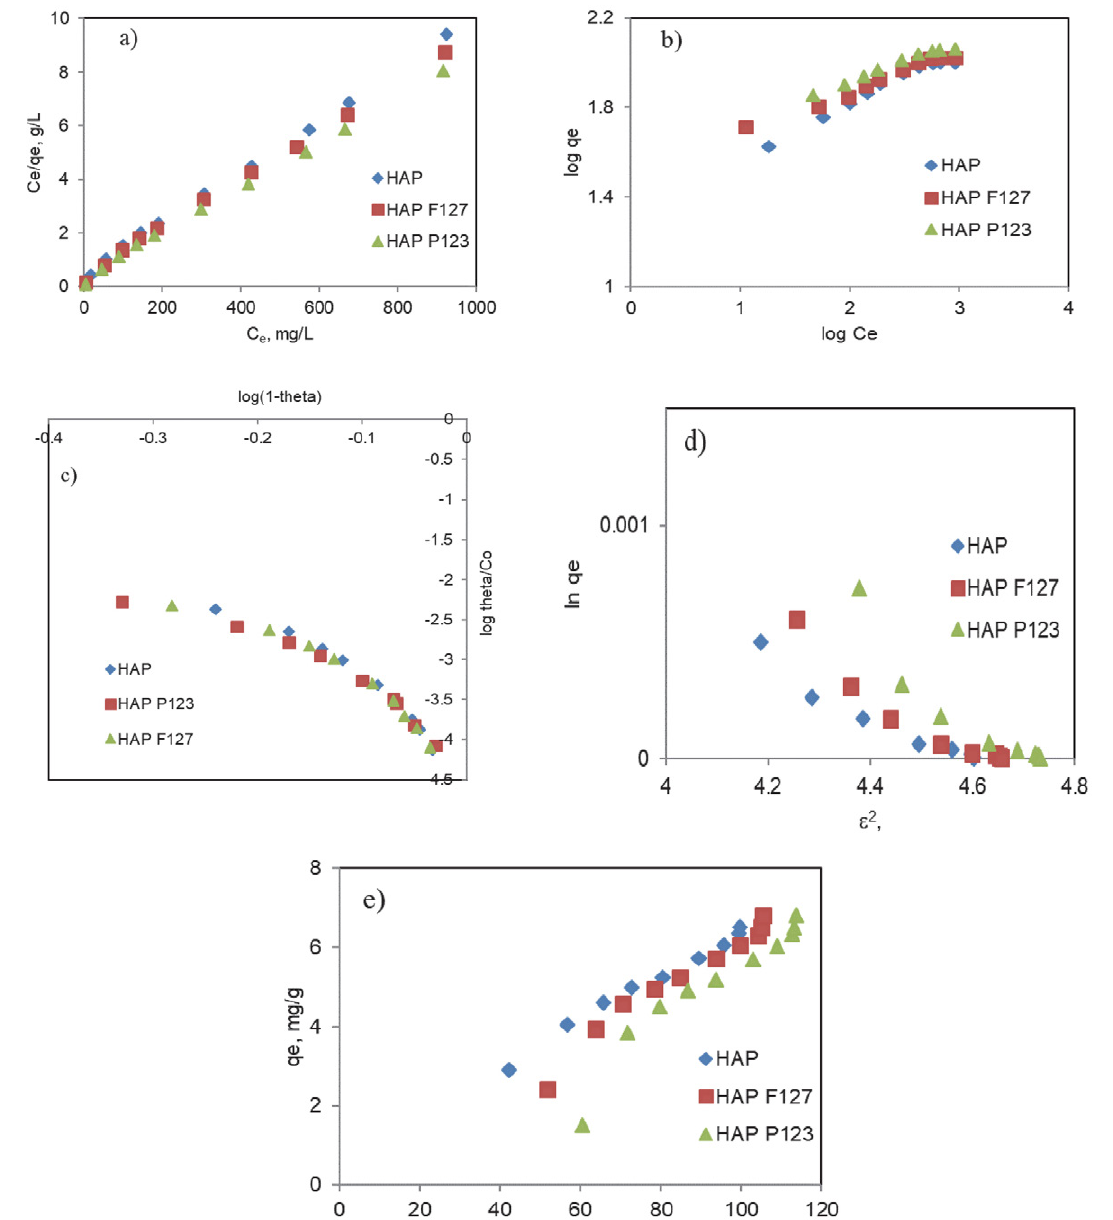
Figure 8. Langmuir (a), Freundlich (b), Flory-Huggins (c), Dubinin-Radushkevich (d) and Temkin (e)